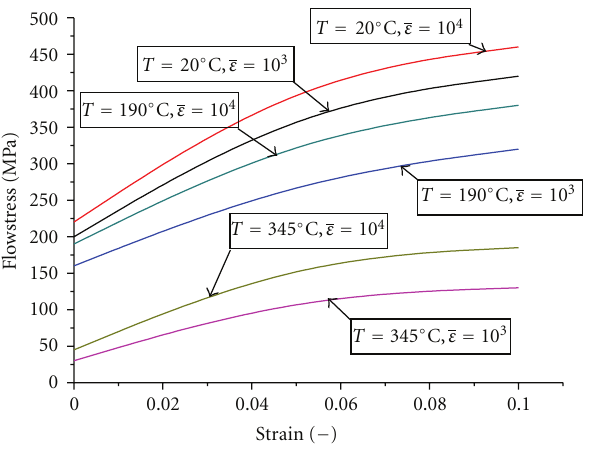
Figure 3: Flow stress for